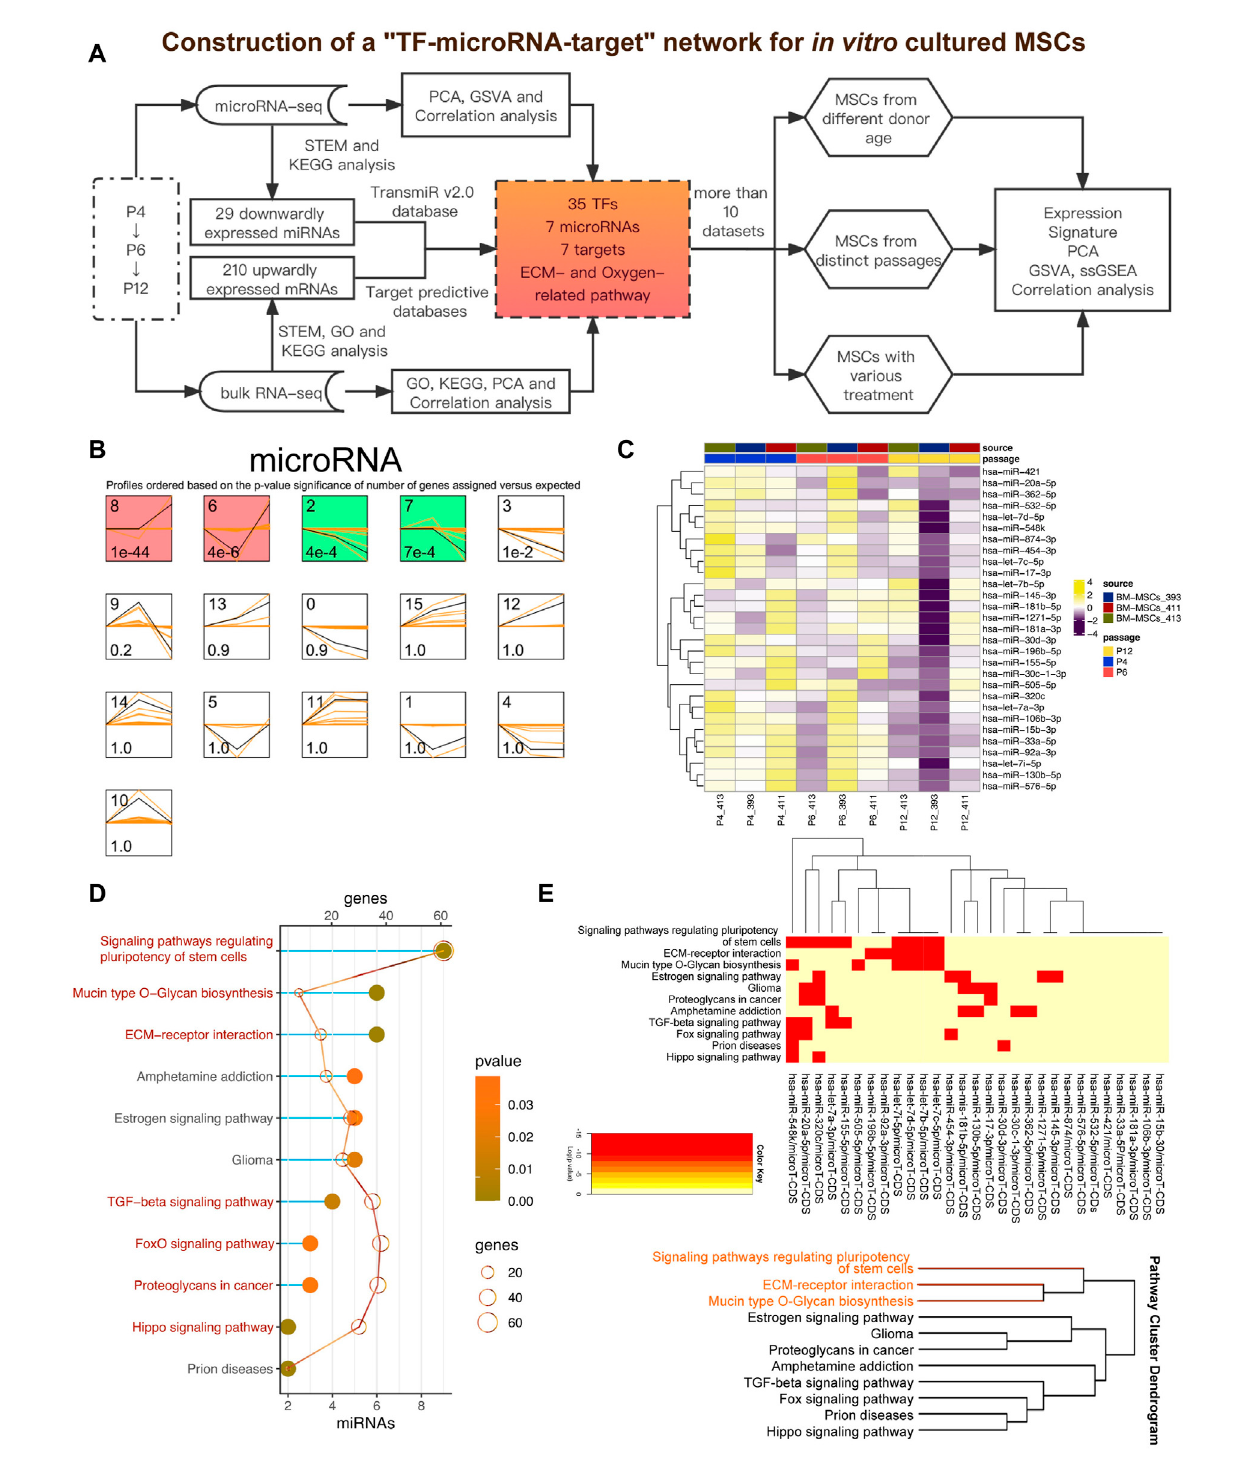
FIGURE 1 Downwardly expressed miRNAs during the passage of MSCs in vitro . (A) Pipeline of the present study. GSE178514 dataset was used for identifying and constructing the network while other datasets were adopted to validate the results. (B) STEM analysis of miRNA-seq data. Signi fi cant pro fi les are colored, and thesamecolorrepresentsasimilarexpressionpattern.Signi fi cantmiRNApro fi lesarecolored,andthesamecolorrepresentsasimilarexpressionpattern,such as gradually increasing or decreasing pattern. (C) Heatmap plots 29 gradually downregulated miRNAs, which was obtained from miRNA Pro fi le 2. (D) KEGG analysis of 29 miRNAs via the DIANA-miRPath database. Top signi fi cant pathways were presented. (E) Clustering analysis of theenrichedpathways and the involved